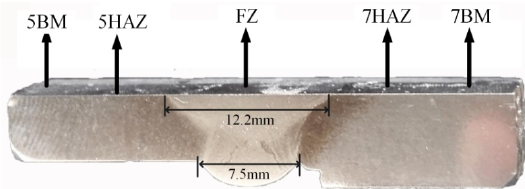
Figure 4. Optical image of the cut-out after electrochemical polishing.